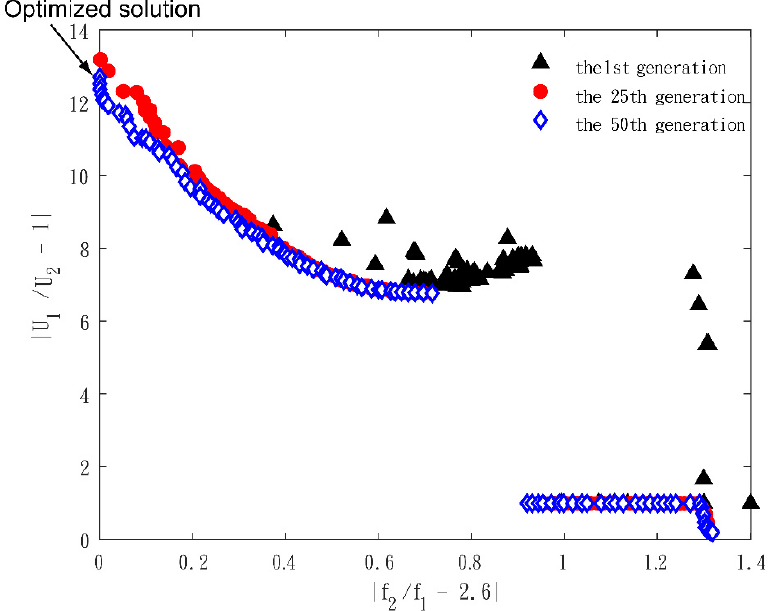
Figure 9. Distribution of the population of several generations in the optimization process for S = 2.6.